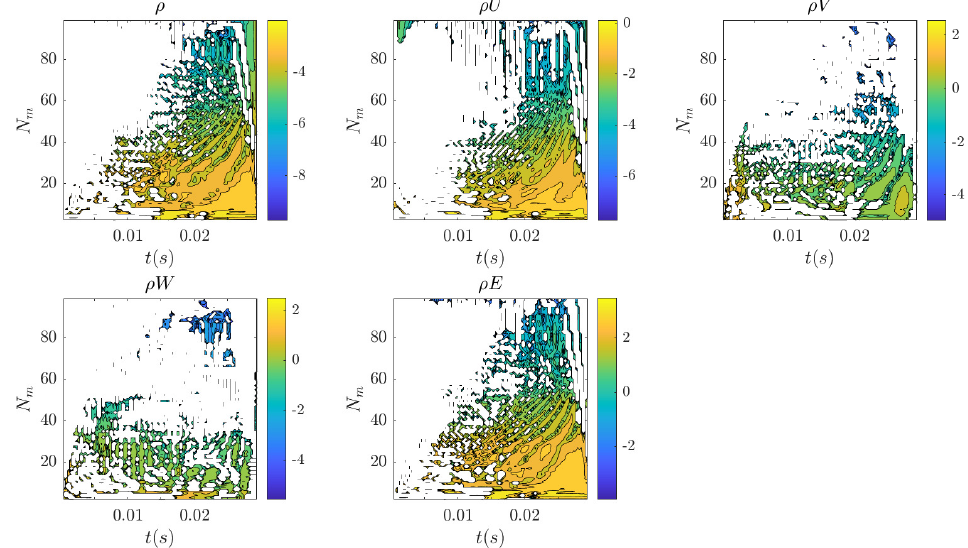
Figure 21. The log 10 ( (cid:101) diff ) considering POD as the reference single ROM, versus time and number of modes, formation flight test case. White regions correspond to (cid:101) diff = 0, i.e., the model based adaptive ROM selects